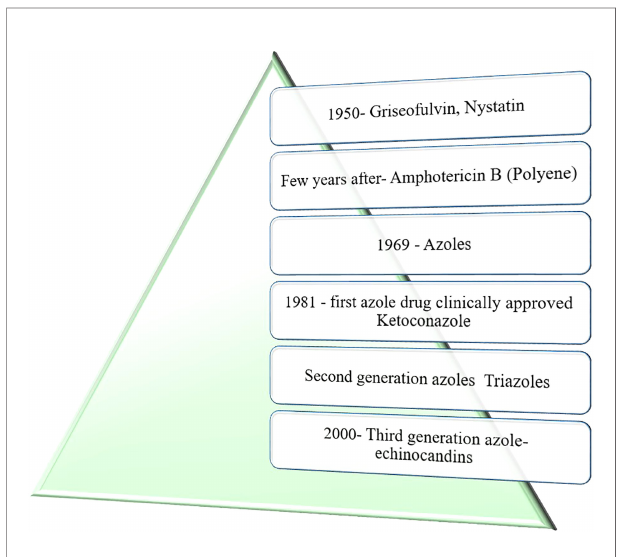
FIGURE 1 | Development of antimycotic